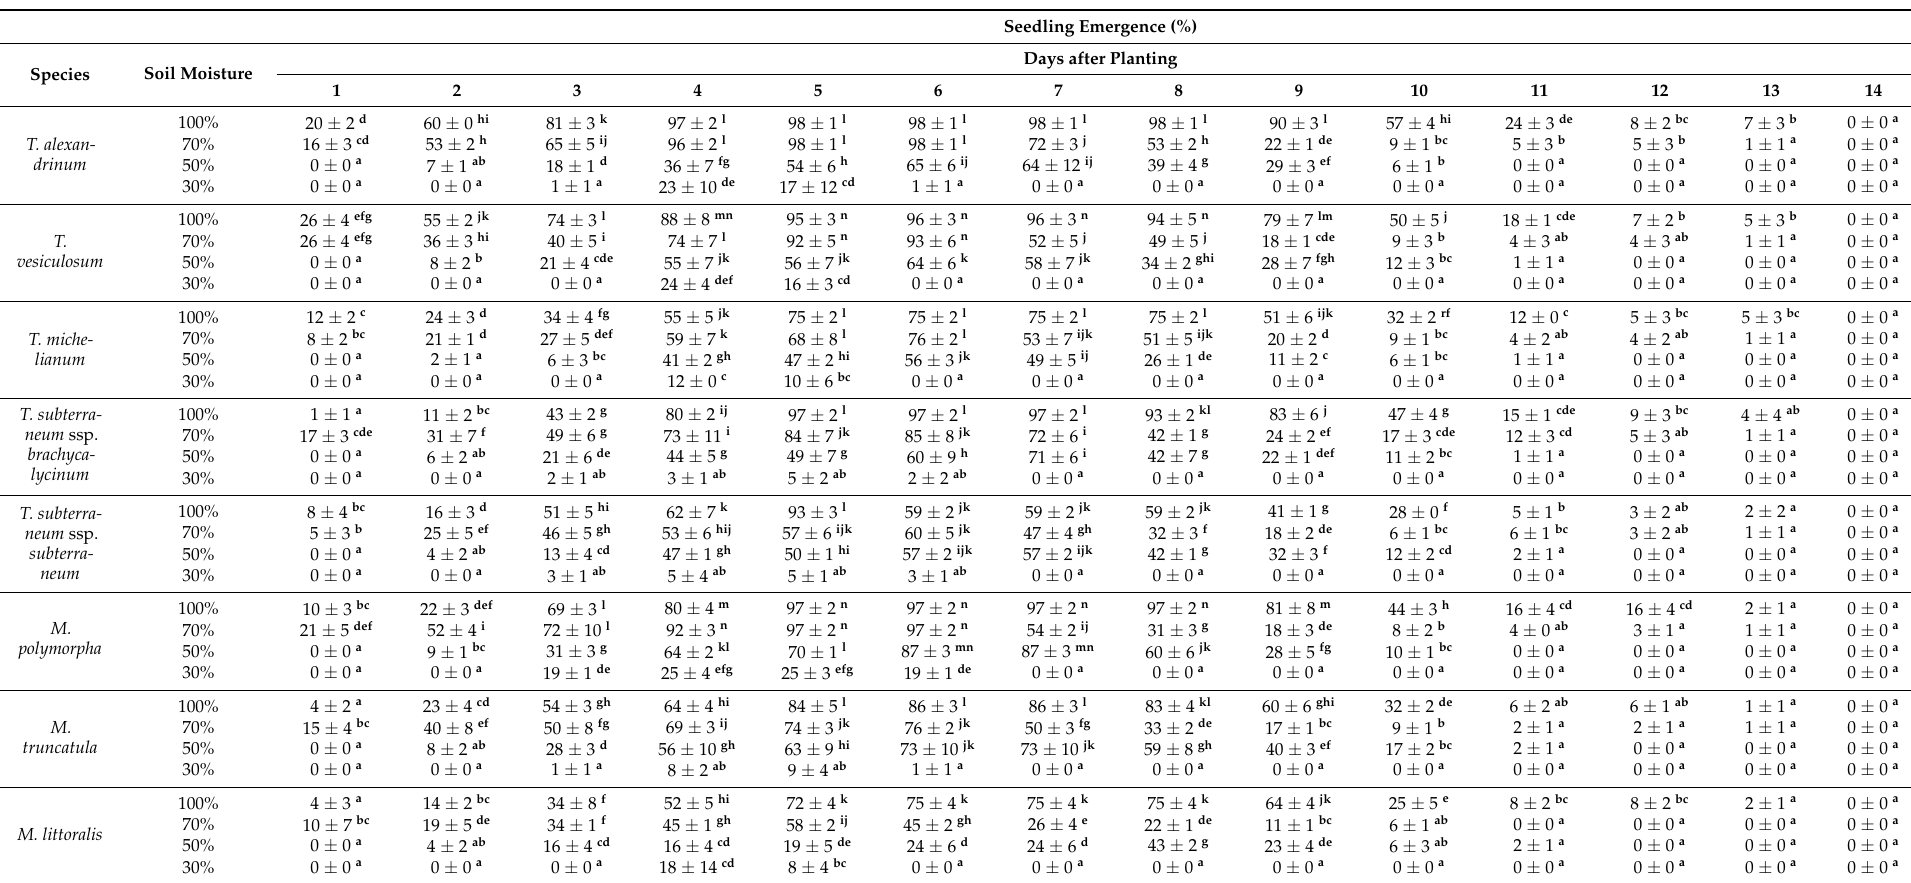
Table 4. Mean ( ± SEM) seedling emergence of three Medicago and five Trifolium species in relation to soil moisture content (% of soil water capacity) at planting. Significant differences ( p < 0.05) in seedling emergence within a species at each planting time and moisture content at planting are indicated by different superscript